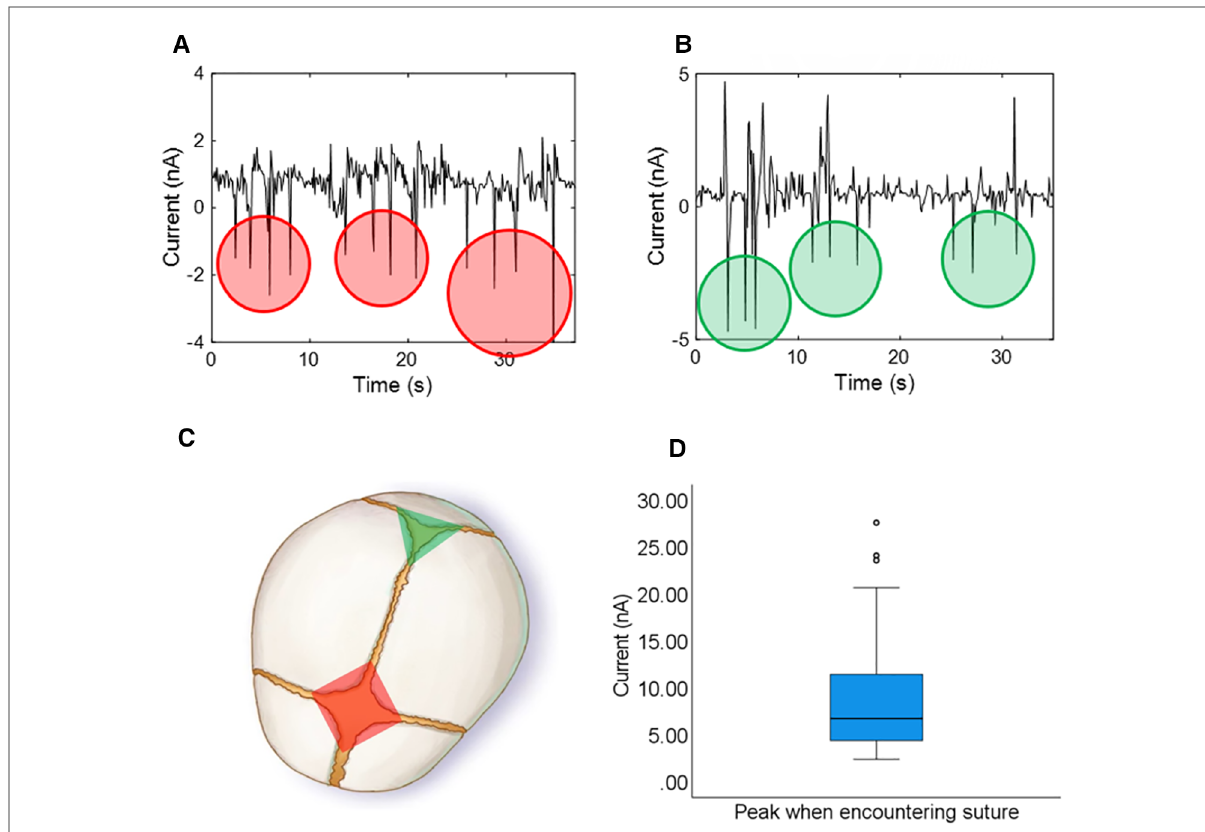
FIGURE 3 Current signal results using the glove to examine skull sutures, and the anterior and posterior fontanelle on the phantom (each peak corresponds to a crossed suture and peaks are counted to distinguish fontanelles – 4 peaks/sutures for the anterior fontanelle and 3 peaks/sutures for the posterior fontanelle). ( A ) Anterior fontanelle results. ( B ) Posterior fontanelle results. ( C ) Schematic representation of the fontanelles and sutures of a fetal head. ( D ) Boxplot showing the amplitude of the current peaks produced when crossing a suture (100